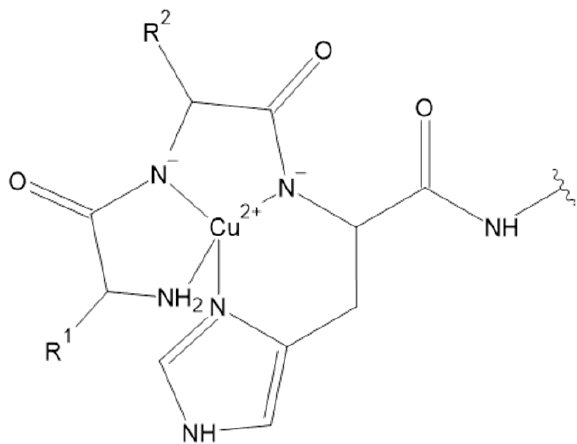
Figure 5. ATCUN motif in Cu(II) complexes